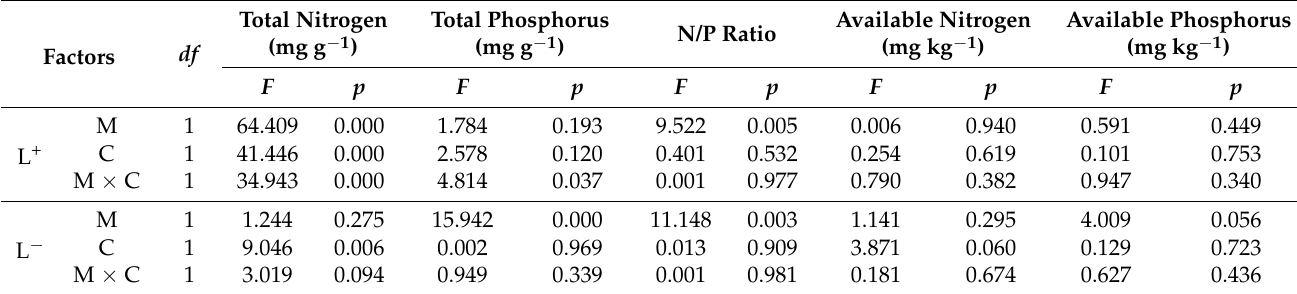
Table 3. Two-Way ANOVAs for the effects of AM fungus (M + vs. M − ) and competition pattern (Intra- vs. Inter- ) on total nitrogen and phosphorus and the N/P ratio and the available nitrogen and phosphorus of soil under L + and L − treatments.